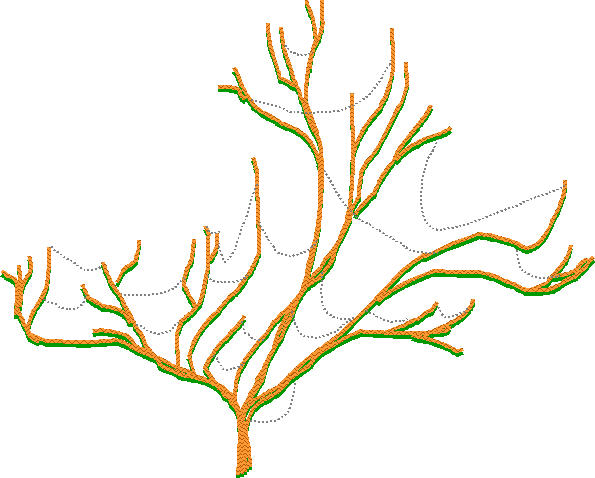
Horizontal gene transfers—gene exchange between non-related organisms—appear commonplace among bacteria, but contribute just small bits of genetic information, leaving the traditional tree of life intact